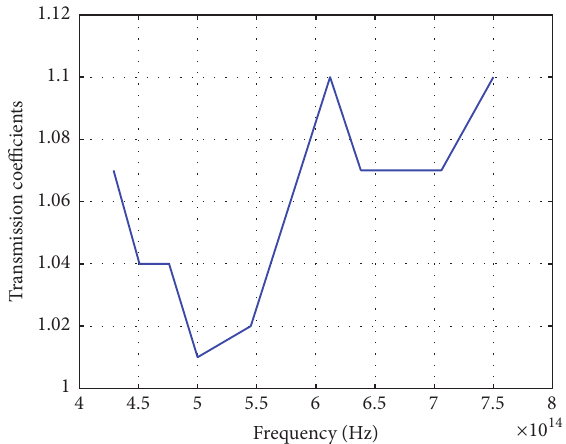
Figure 19: Variations in transmission coefficient with frequency for a radius ratio of 2 with fixed inner and outer radius values.